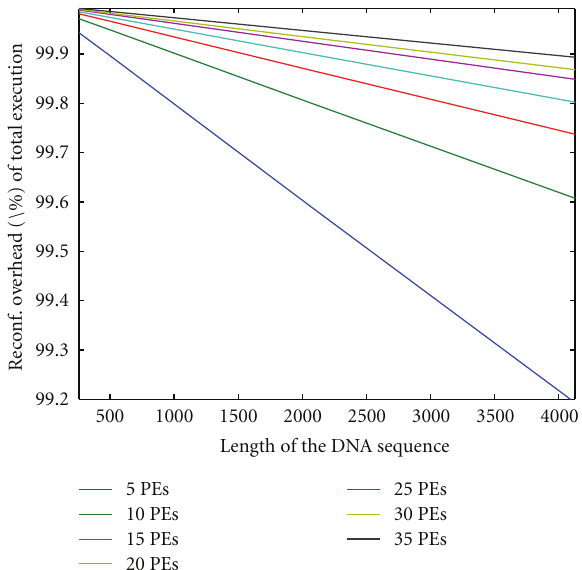
Figure 9: Fraction of the total time spent on reconfiguration, with increasing DNA sequence length, based on measurements on the test